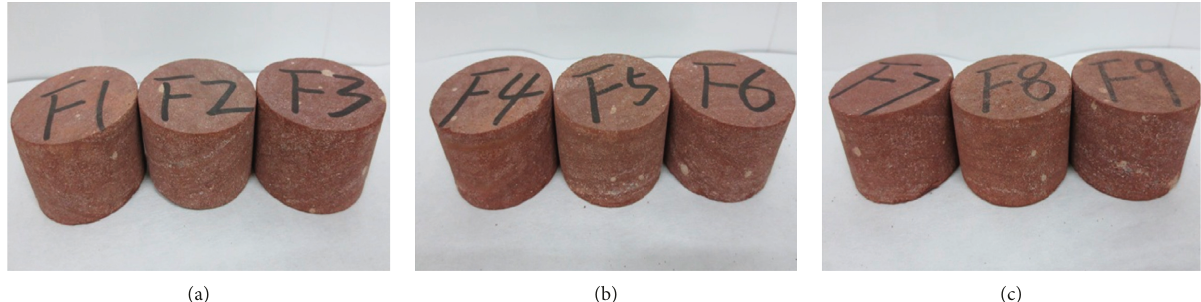
Figure 4: Specimens macroscopic observation after different numbers of freeze-thaw cycles in pure water: (a) 10 cycles; (b) 20 cycles; (c) 30